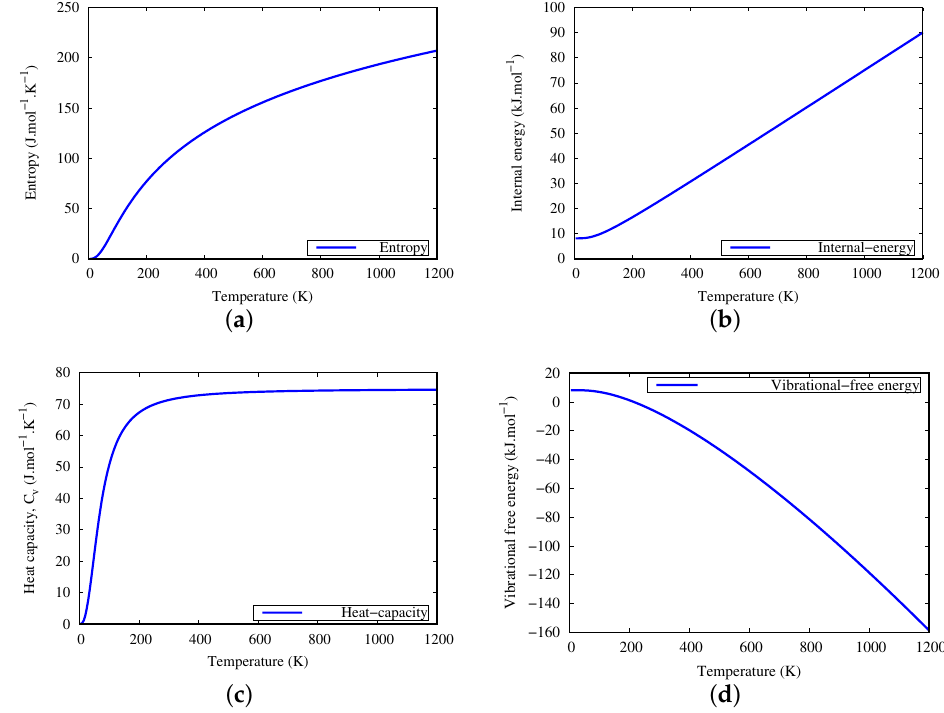
Figure 3. Thermodynamic properties of HfIrAs